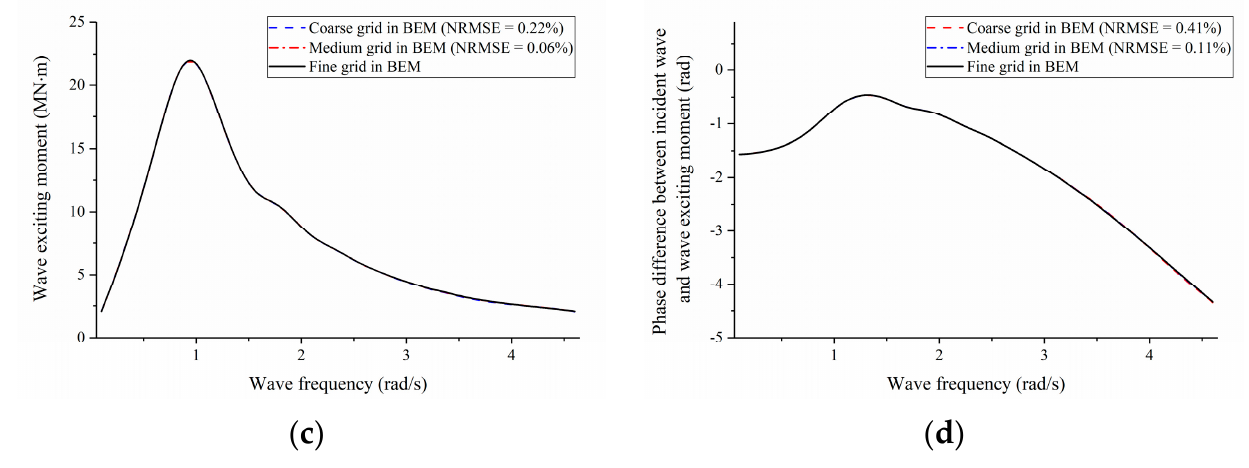
Figure 5. The comparison of the hydrodynamic coefficients under unit-amplitude regular waves for different element sizes in BEM: ( a ) the added inertia torque µ ( ω ) ; ( b ) the radiation damping c ( ω ) ; ( c ) the wave exciting moment M e ( ω ) ; ( d ) the phase difference between the incident wave and the wave exciting moment ψ ( ω ) .